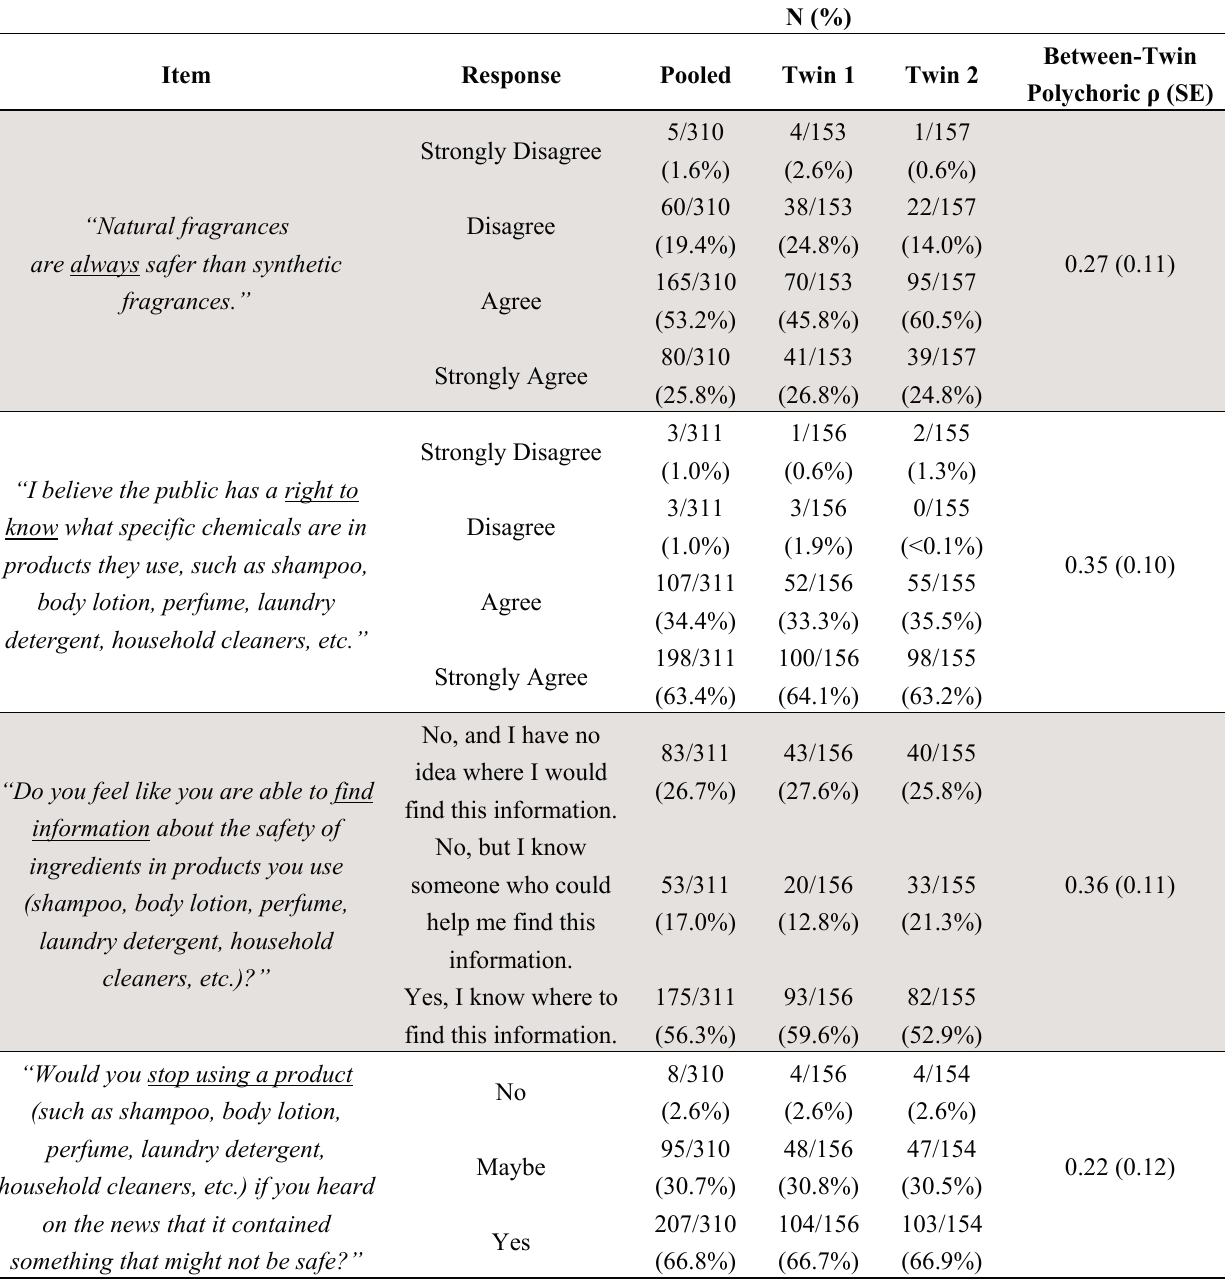
Table 1. Attitudes toward chemical safety. Black and white participants are pooled in this table ( N = 314) because for these items responses did not differ significantly by race. Missing data per